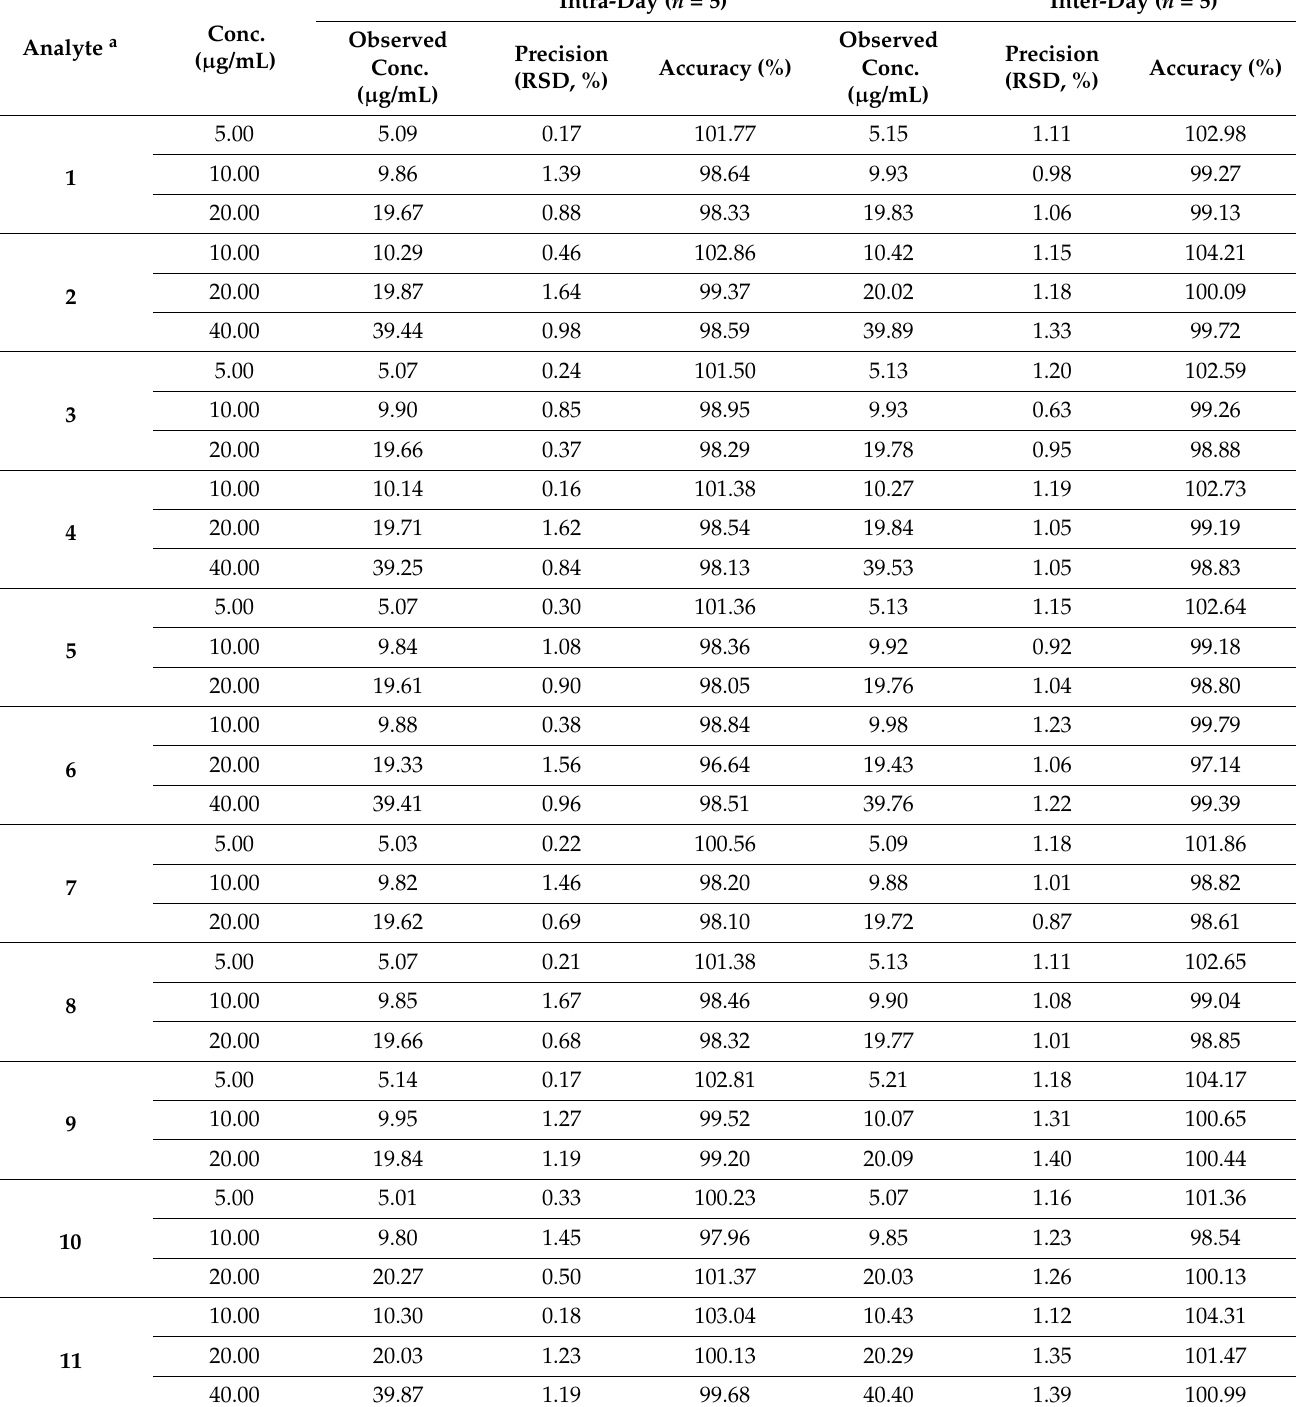
Table 4. Validation of the precision of the developed HPLC method using 11 analytes.